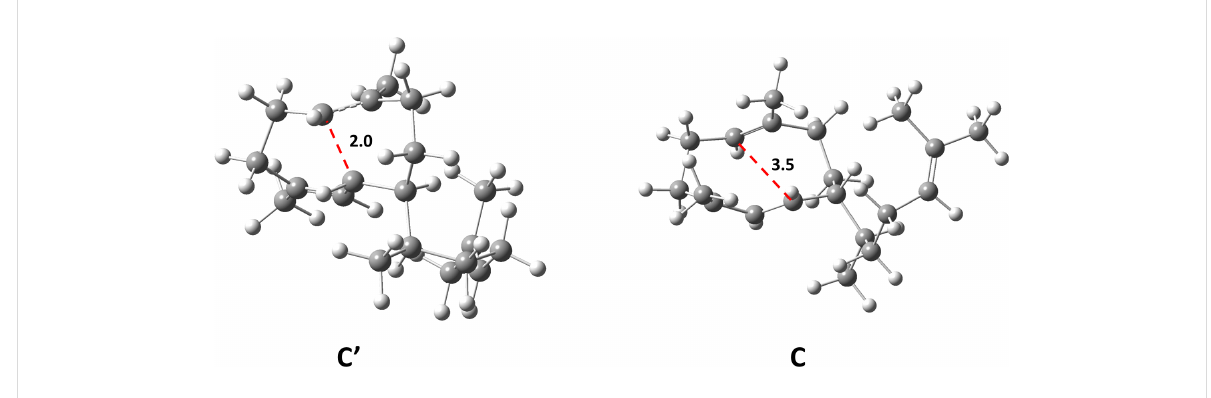
Figure 3: Structures of intermediates C ‘ and C . The distance between the double bond and the cation in intermediate C‘ is 2.0 Å while in C the dis- tance is 3.5 Å.